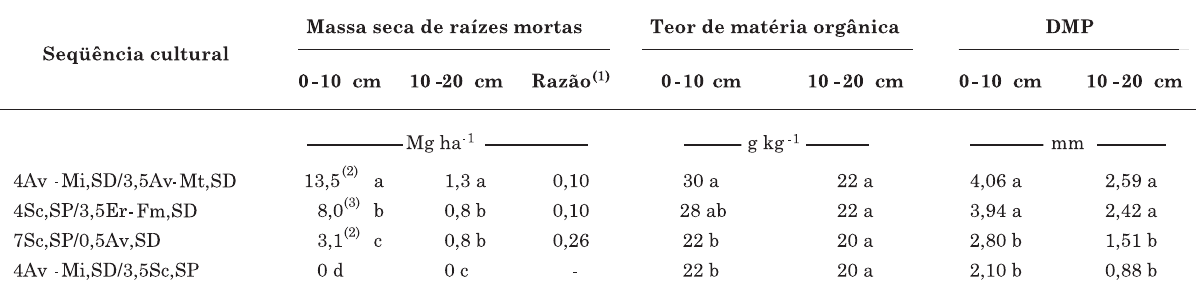
Na figura 2, são apresentados os resultados